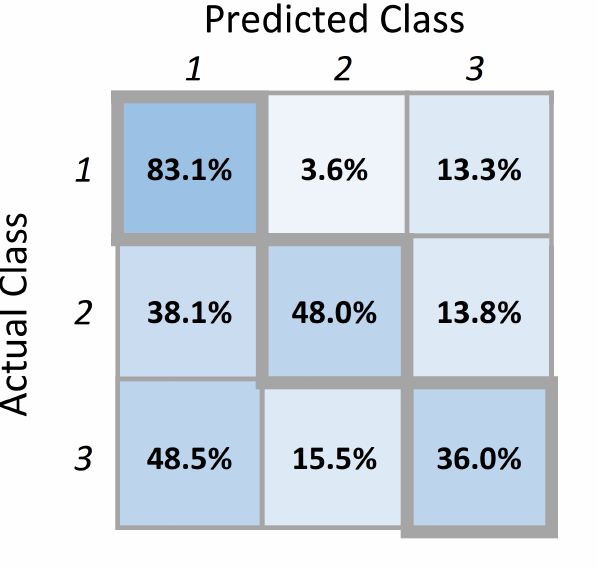
Figure 17. Confusion matrix from the evaluation with Multiclass Logistic Regression. Multiclass Neural Network makes use of Neural Networks to perform the